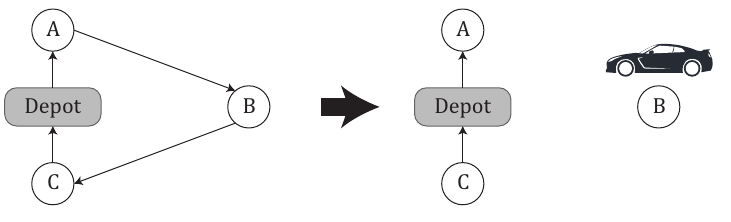
Figure 5. Example of Out-move of